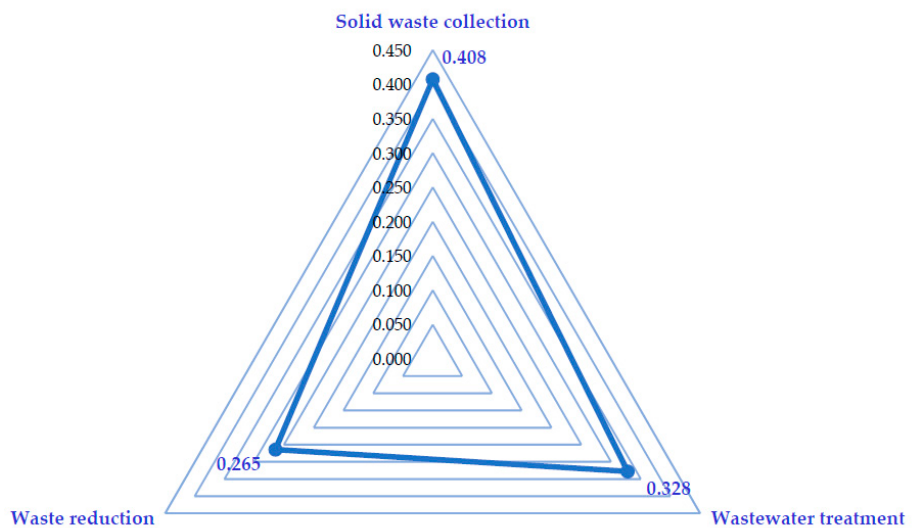
Figure 12. Relative weights of the assessment indicators for “Waste Management”.